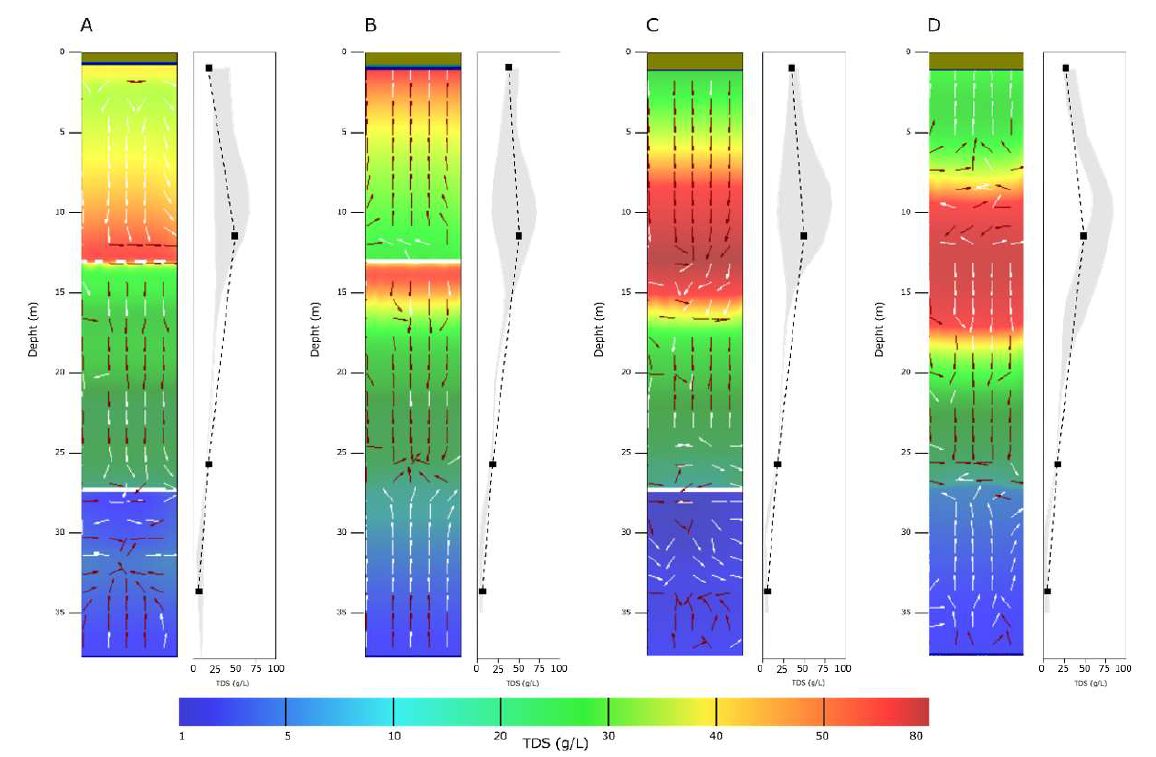
Figure 6. Profile of TDS concentrations versus depth (meters below ground surface) for different periods of the simulation (see Figure 2). ( A ) From January 2010 to June 2010 (i.e., 15 April); ( B ) From July 2010 to April 2011 (i.e., 15 September); ( C ) From May 2011 to July 2011 (i.e., 15 June); ( D ) From August 2011 to October 2011 (i.e., 15 September). Black squares: Mean values of TDS-calculated data (see Table 1) are shown for the surface water, GW-12, GW-26, and GW-34 together with light- grey-shaded area which represents the concentration range covered in the respective period by the minimum values simulated along with each model